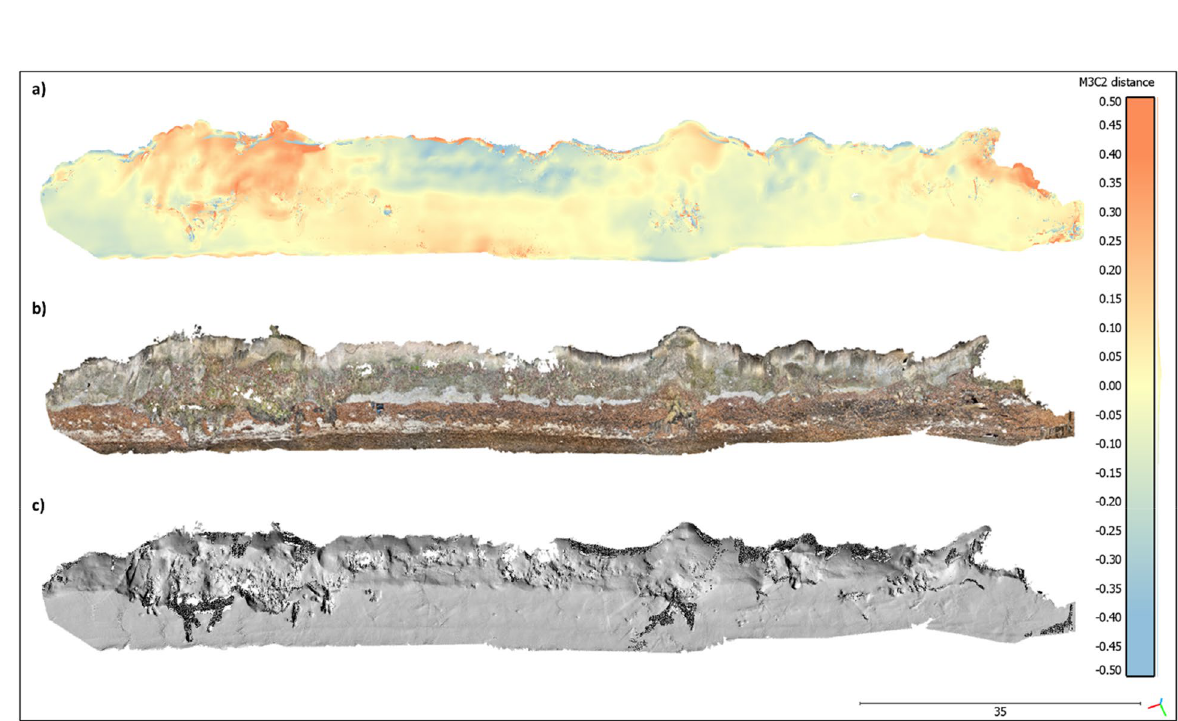
Figure 4. M3C2 distances in meter between SfM MVS reference point cloud and iPhone point cloud, fine registration error RMS: 0.052 m computed on 5 million points with a theoretical overlap: 75%, point clouds subsampled to 0.05 m minimal nominal spacing between points with normal directions and projection diameter calculated at 1.33 m for each point ( a ), textured iPhone LiDAR model of the cliff ( b ) iPhone LiDAR hillshade model of the cliff ( c ). Scale bar in bottom right indicates 35